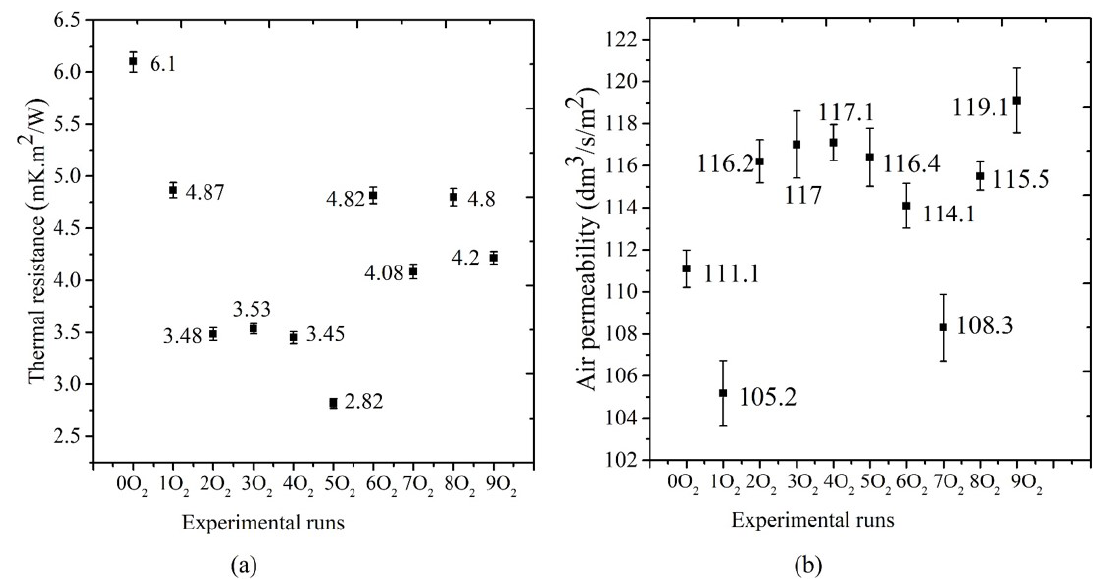
Figure 5. Effect of oxygen plasma on thermal resistance (a) and air permeability (b) of the